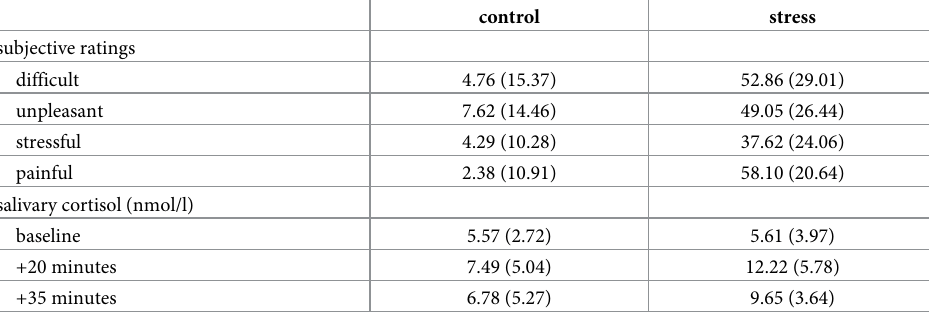
Table 1. Mean (SD) subjective ratings and salivary cortisol in the stress and control